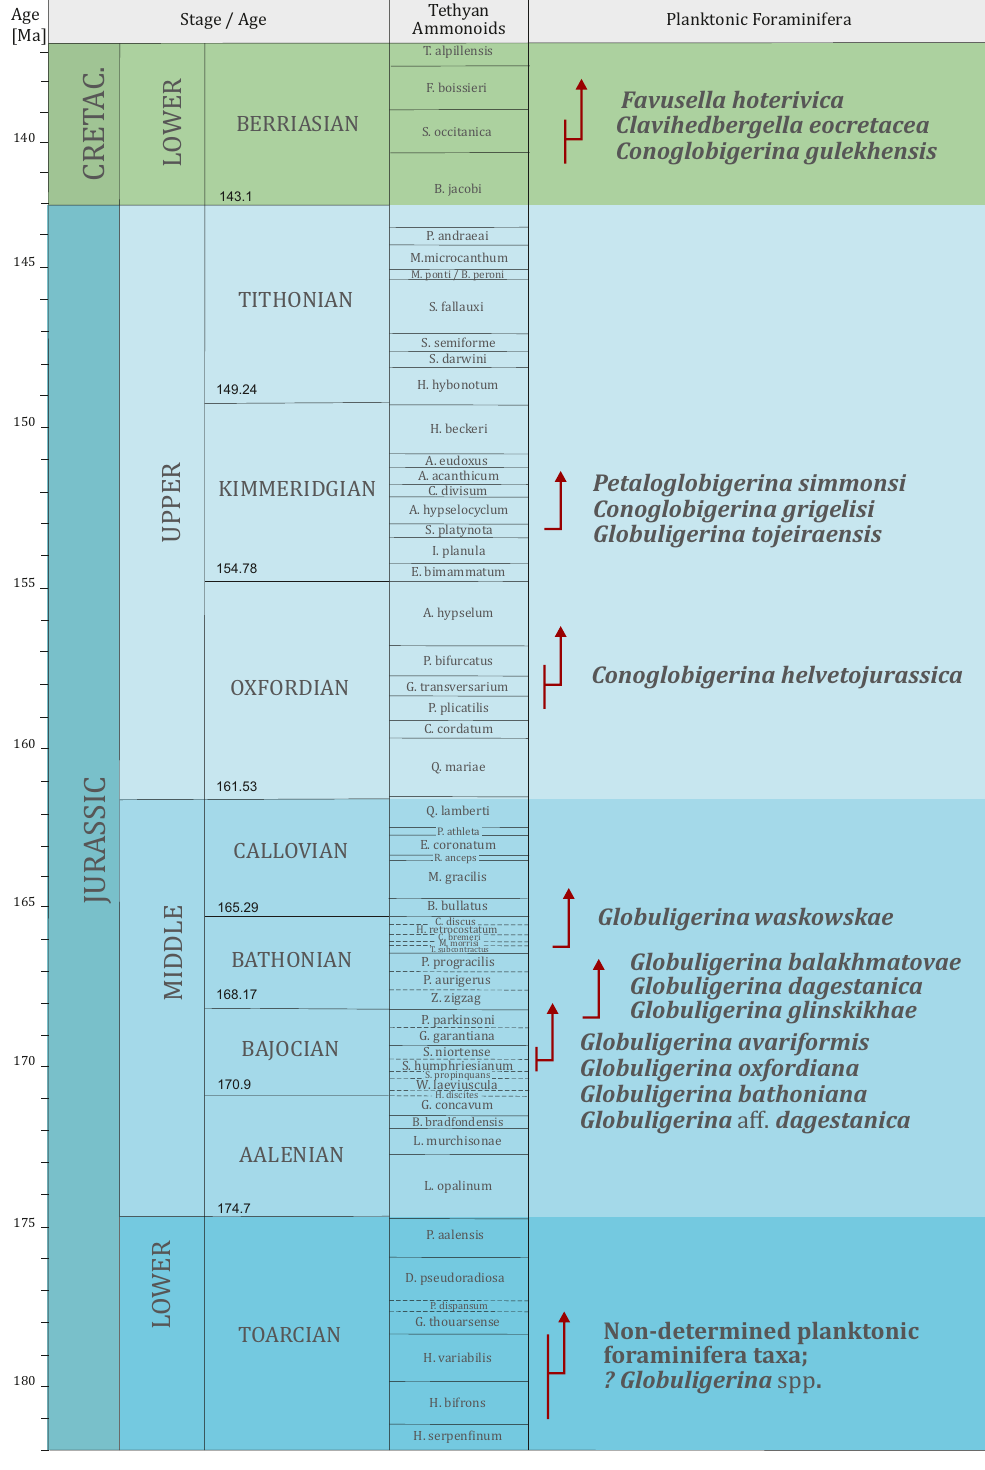
Figure 4. First Appearance Datum (FAD) of species of Jurassic planktonic foraminifera, calibrated to ammonite and nannofossil stratigraphy, as outlined in the text. Event level uncertainty beyond the duration of the ammonite zone(s) in which FAD’s were determined is not taken into account in this